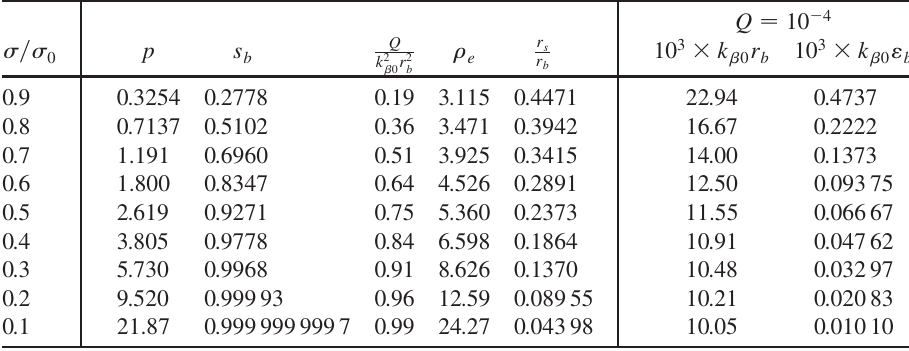
For large relative space-charge intensity ( (cid:3)=(cid:3) flatness of the contours deep within the core of the distri- bution indicates nearly force-free motion until the particle enters the nonlinear edge region. Various parameters for the equilibria presented in Figs. 15 and 16 are given in Table IV. To load the parabolic equilibrium distribution in either direct-Vlasov or PIC simulations, the general framework TABLE IV. Dimensionless parabolic equilibrium parameters in Figs. 15 and 19 calculated for " . The values of k are evaluated for Q ¼ 10 (cid:1) 4 , and all other quantities are specified (cid:3)=(cid:3) (cid:5) 0 b 0 independent of Q